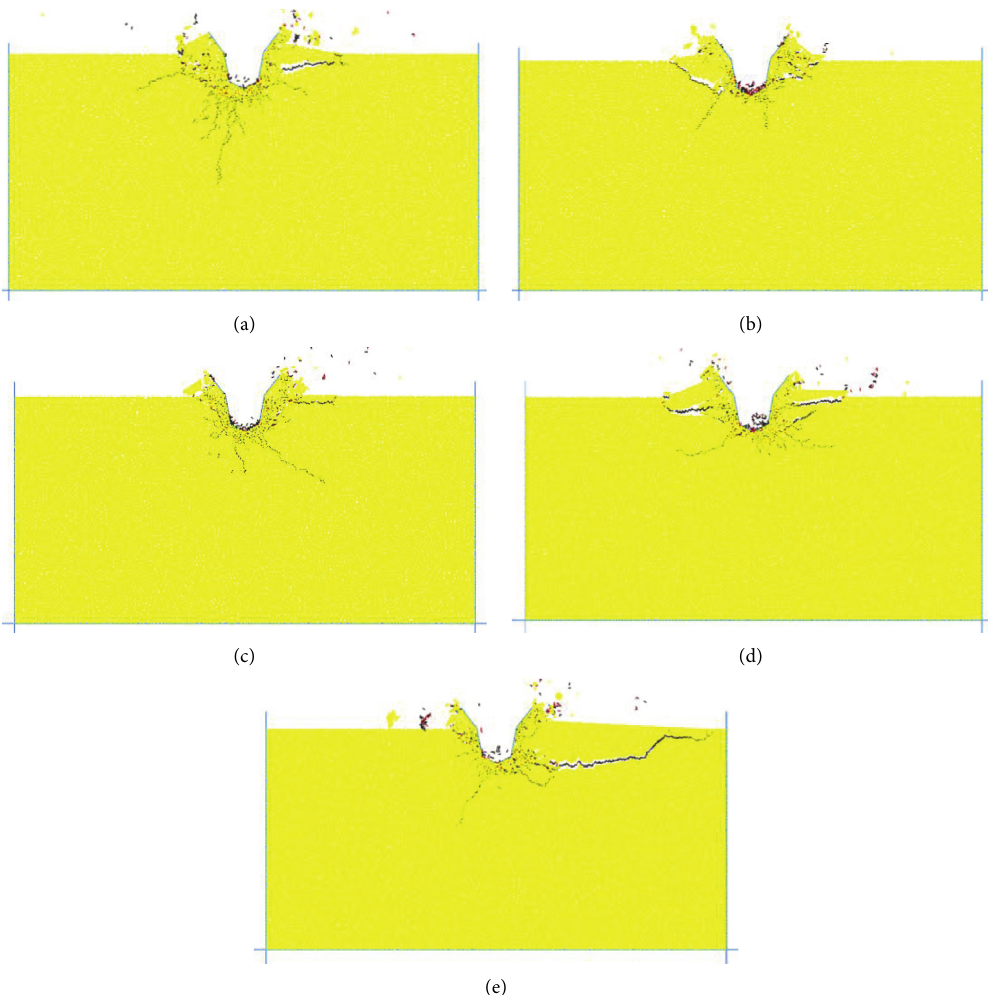
Figure 6: Failure characteristics of rock mass under different confining pressures: (a) 0.0MPa, (b) 10.0MPa, (c) 20.0 MPa, (d) 30.0MPa, and (e)